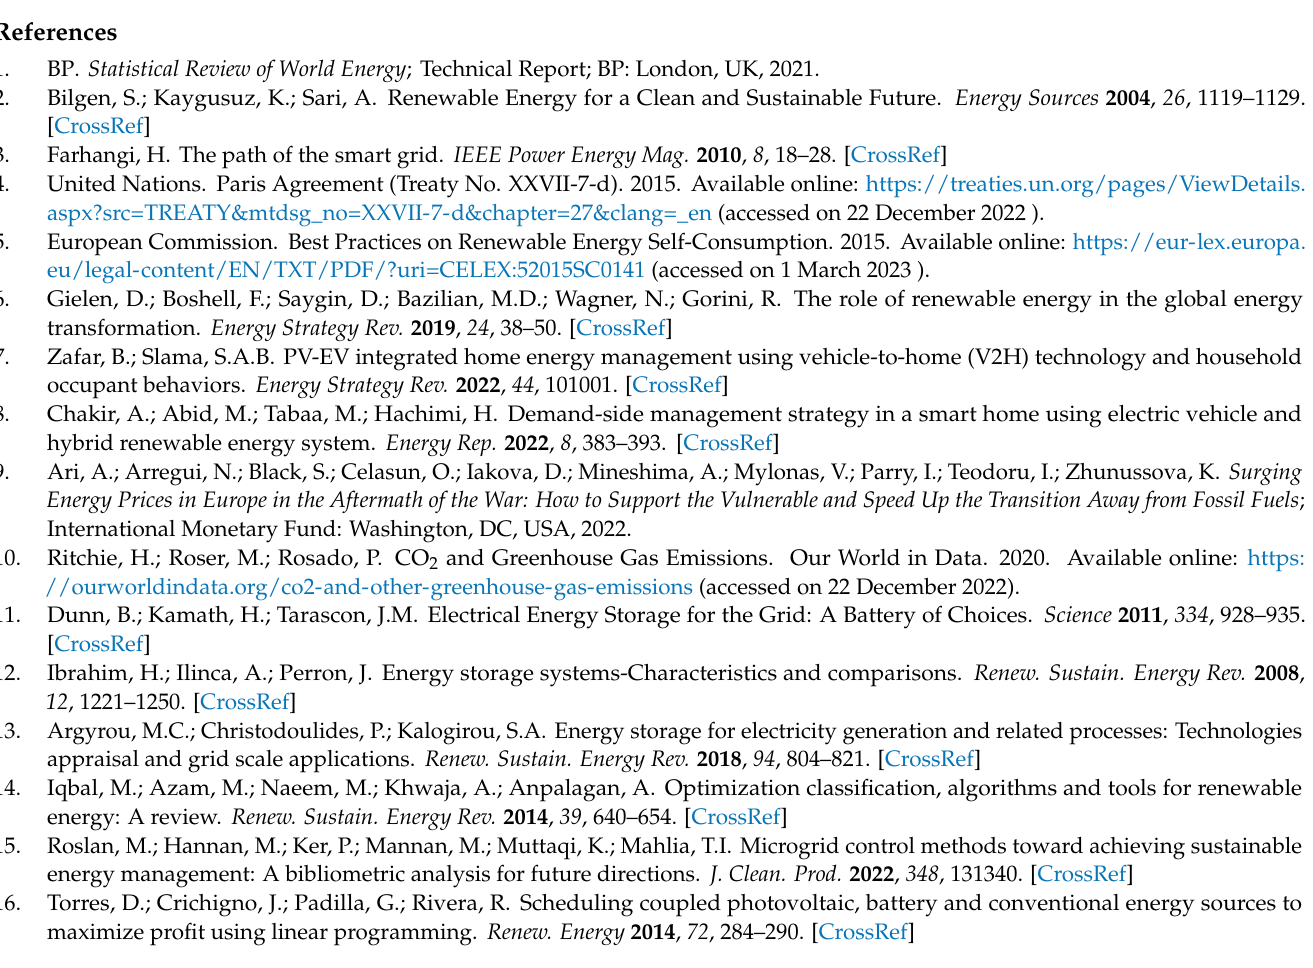
Figure A4. Part 2: Overview of operational profits per prosumer for the baseline and smart battery scheduling algorithm using various sizes for the lookahead window ( κ ) and various sizes for the battery per prosumer ( ω / N ) on original historical data of